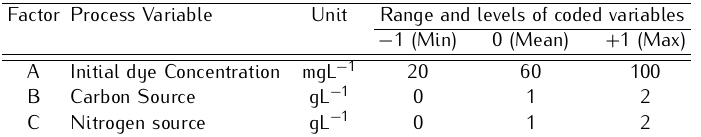
Table 2. Experimental range and level of the input variables.